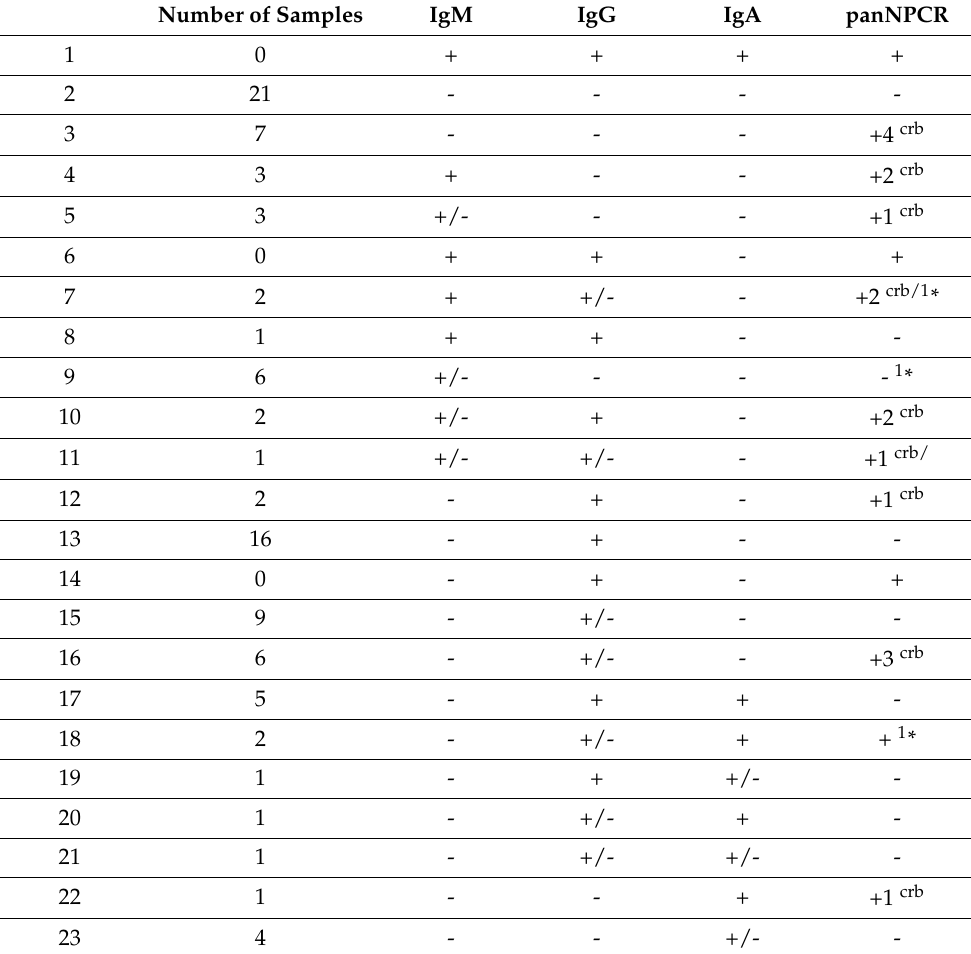
Table 5. ELISA vs. panNPCR in blood—summary. Number of